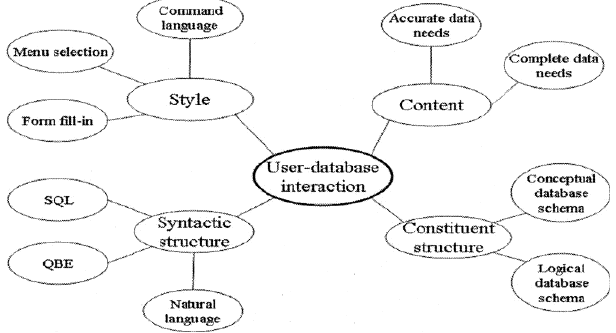
Figure 7. Semantic Map